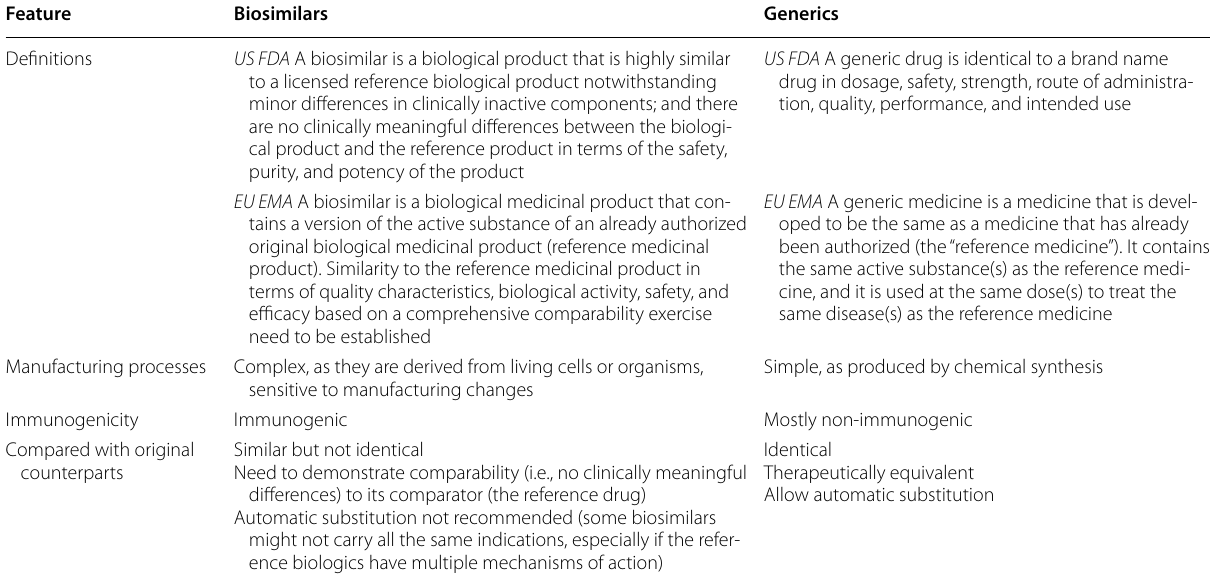
US the United States; FDA the Food and Drug Administration; EU the European Union; EMA the European Medicines